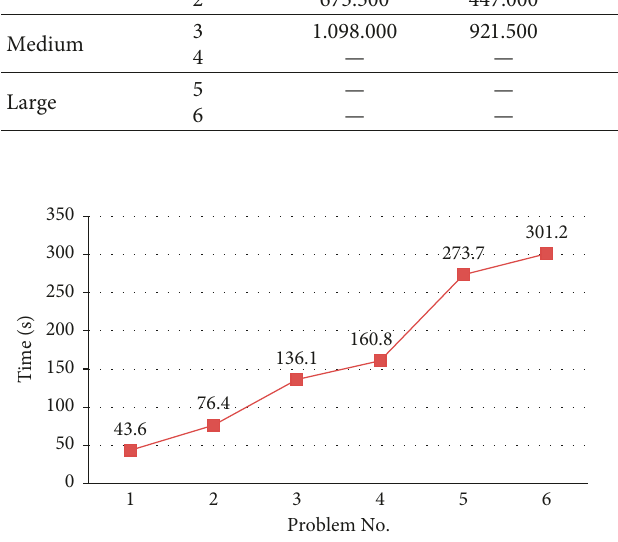
Figure 12: Confidence level effect on total